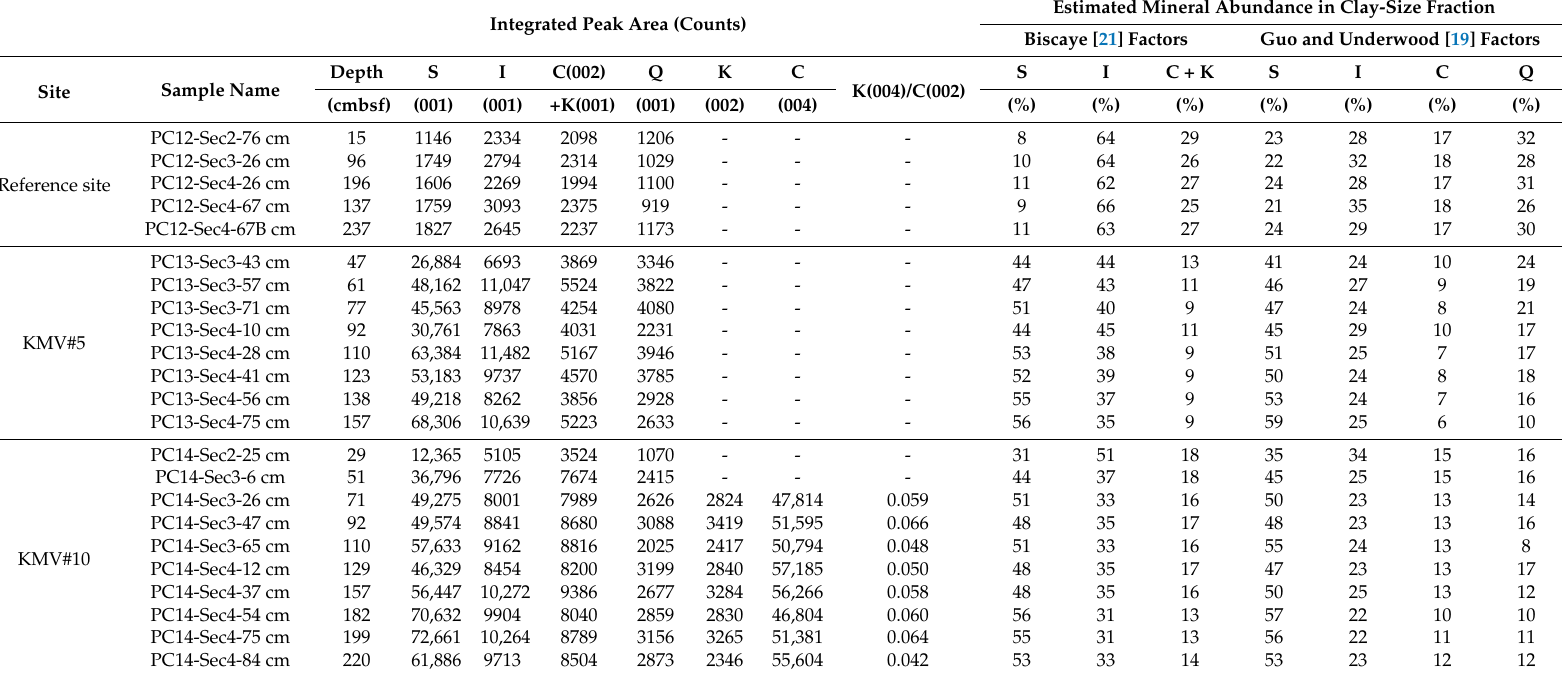
Table 1. Clay mineralogy of samples from the reference site, KMV#5, and KMV#10 (I, illite; S, smectite; C, chlorite; K, kaolinite; Q,